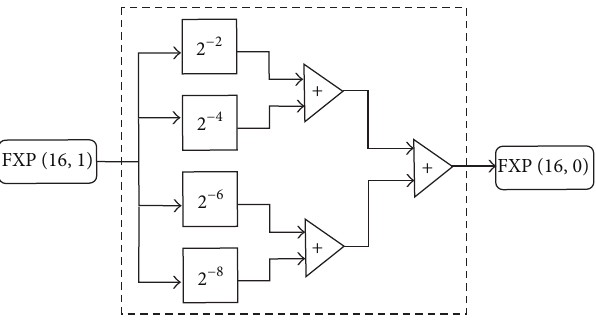
Figure 1: Multiplication by the use of adders and decimal point